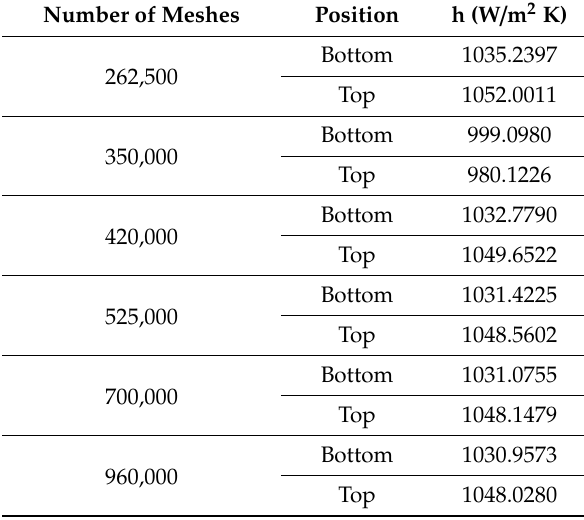
Table 2. Grid independence study conducted for the developed model in the present